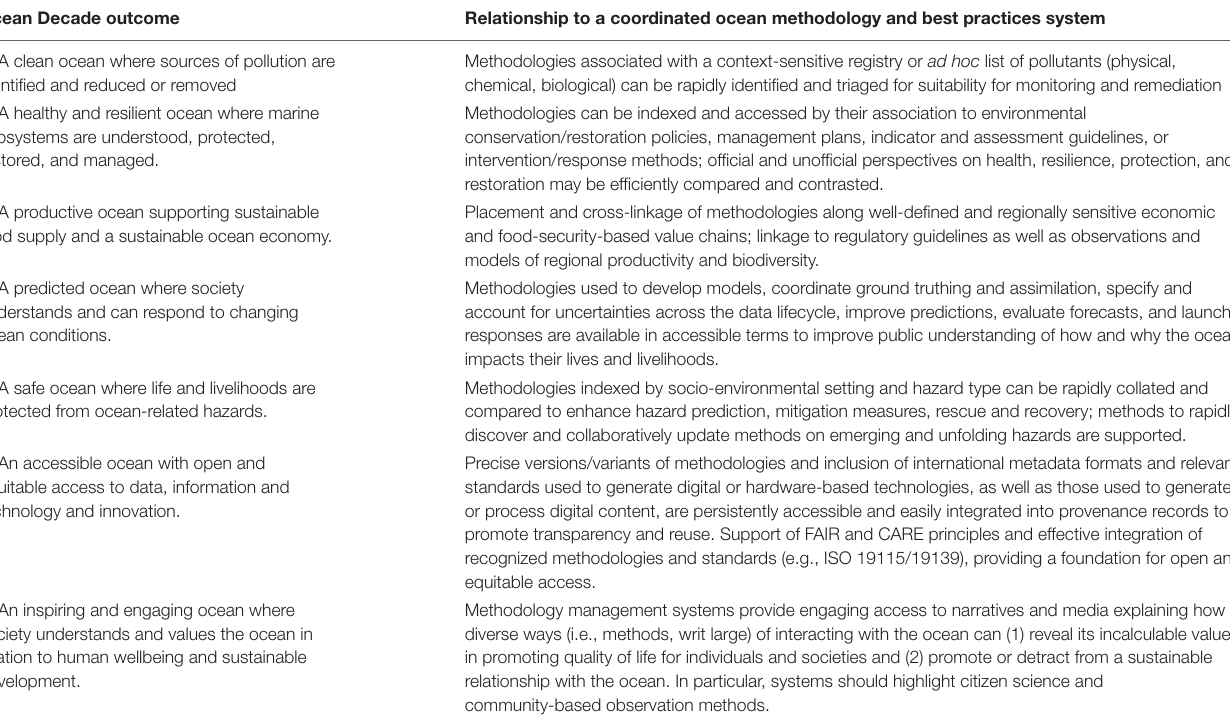
TABLE 1 | The UN Ocean Decade outcomes and how they can each be supported by systematic handling of methodological content (methods, standards, policies, etc.) and identification of best practices. Ocean Decade outcome Relationship to a coordinated ocean methodology and best practices